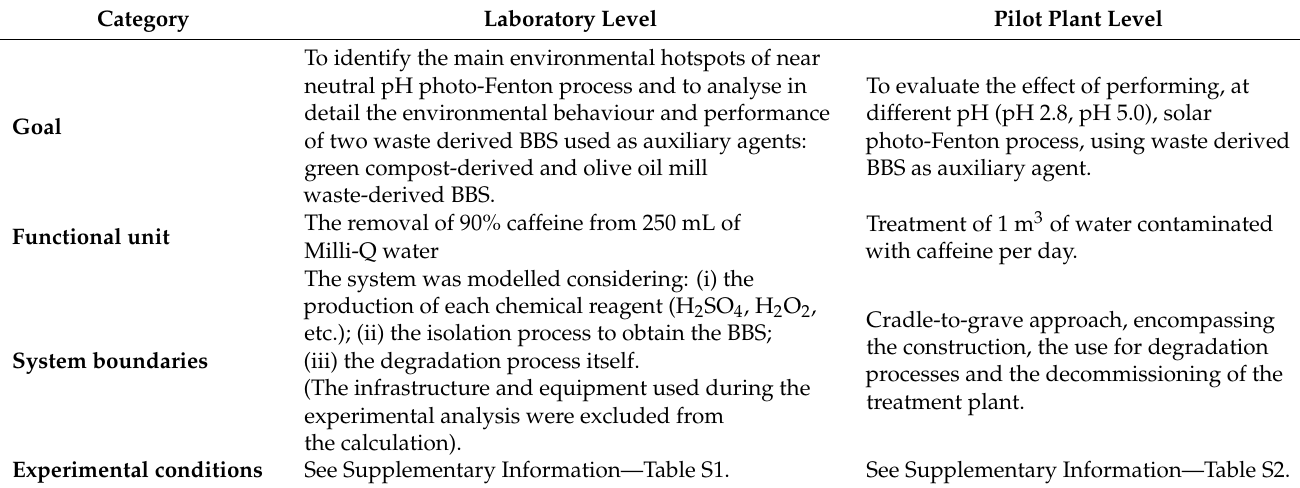
Table 1. A goal and scope scheme for the two parts of the